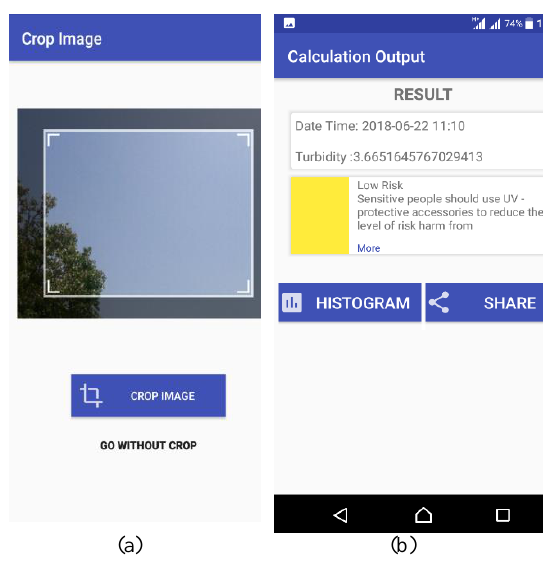
Figure 5 : (a) GPS alert (b) Interactive selection of the